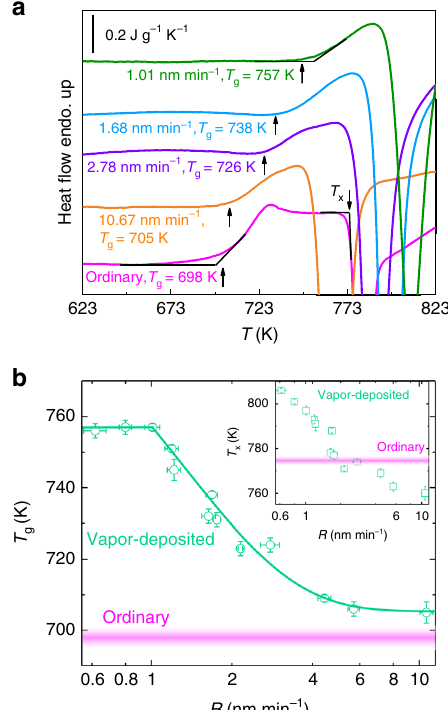
Fig. 1 Effect of vitri fi cation routes on the glass transition and crystallization. a Representative DSC traces at a heating rate of 20 K min − 1 for Zr 46 Cu 46 Al 8 MGs: ordinary glass produced by melt-spinning technic; vapor-deposited glass fi lms at different rates as denoted below each curve. T T fi ned from the onset of the transformation as indicated by g and x are de the intersection of the black lines. b T g vs. R . The solid line at high R is an exponential fi t to the data, at low R the T g keeps invariant. Inset: T x vs. R . The error bars indicate the standard deviation of three to fi ve measurements. For comparison, the T g and T x with their variation ranges for the ordinary glass are presented by the shaded magenta